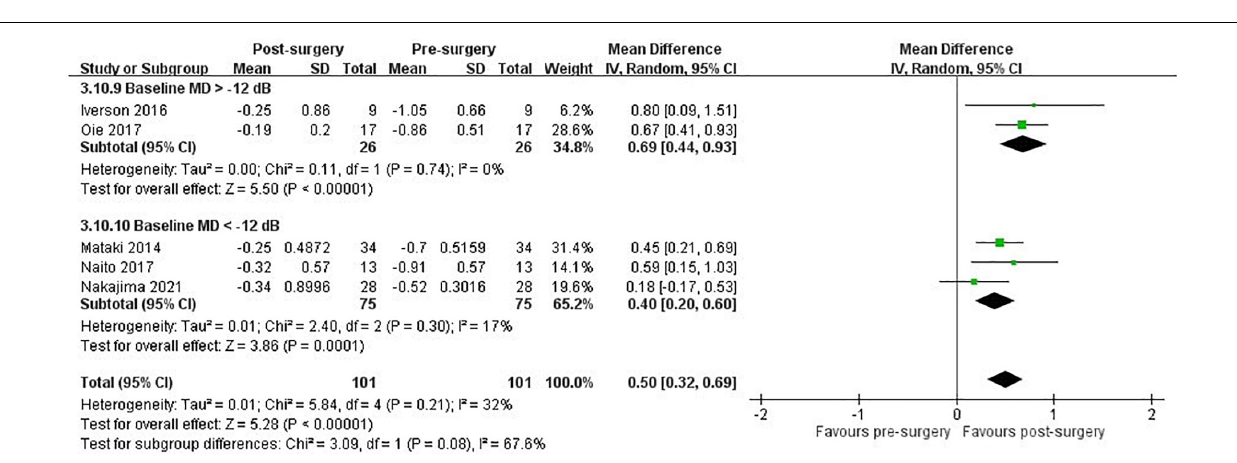
FIGURE 2 | VF progression with MD slope in patients with NTG after trabeculectomy.